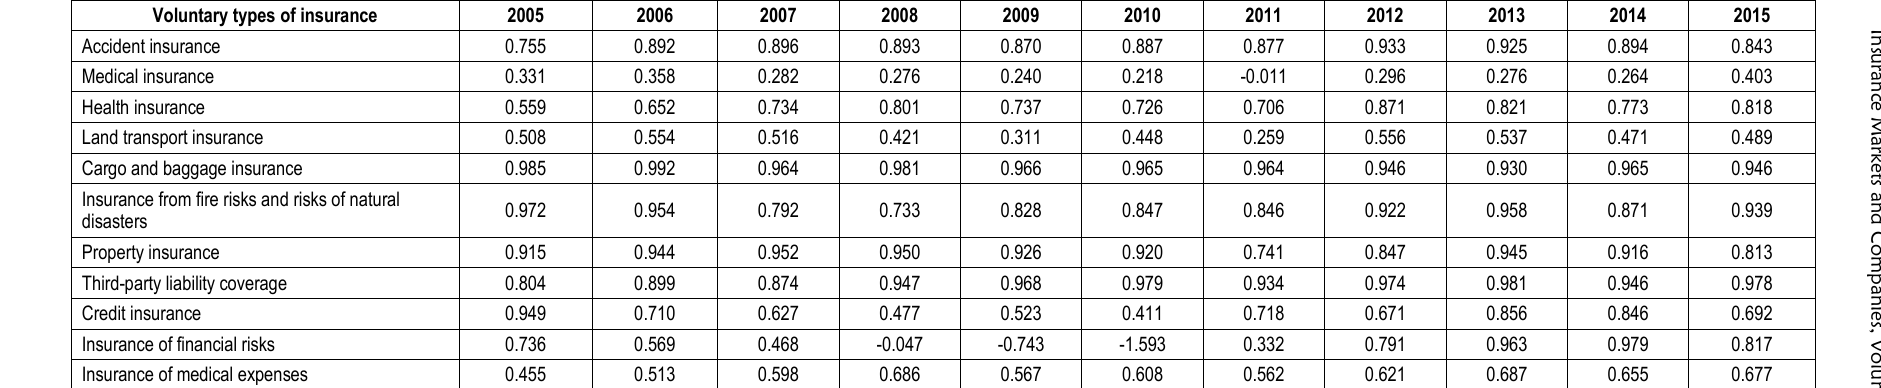
Table 3. Indicators of profitability of the voluntary types of insurance in 2005 – 2015, thousand